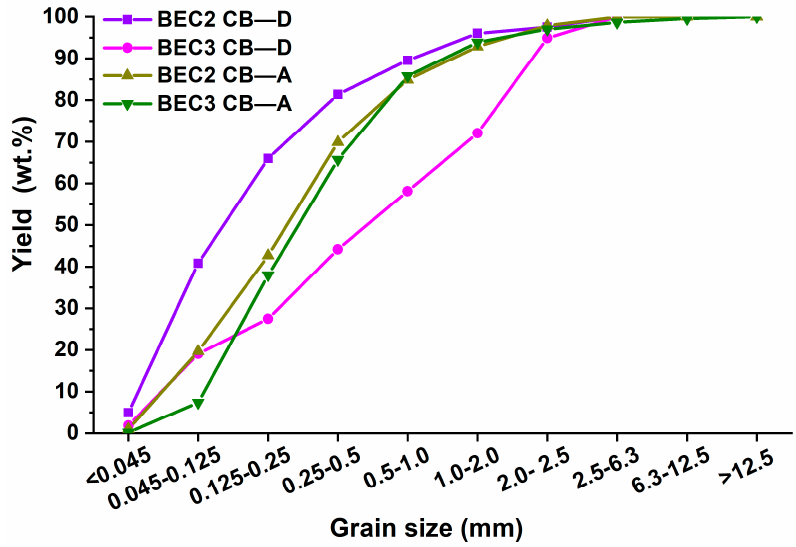
Figure 7. The grain size analysis of combustion products from coal briquettes.